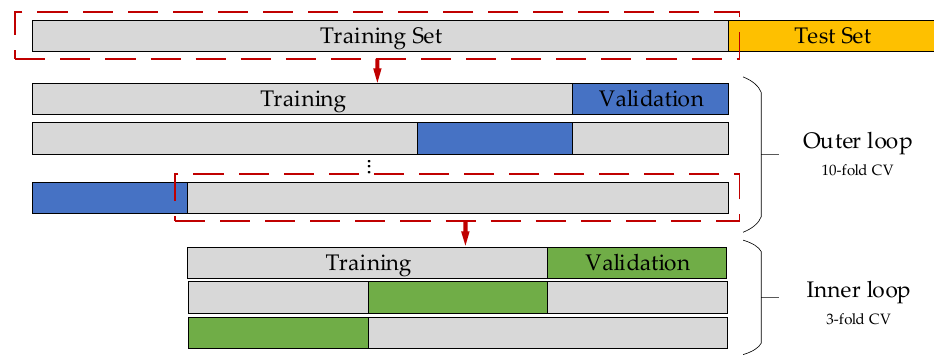
Figure 6. Graphical representation of the nested cross ‐ validation procedure.